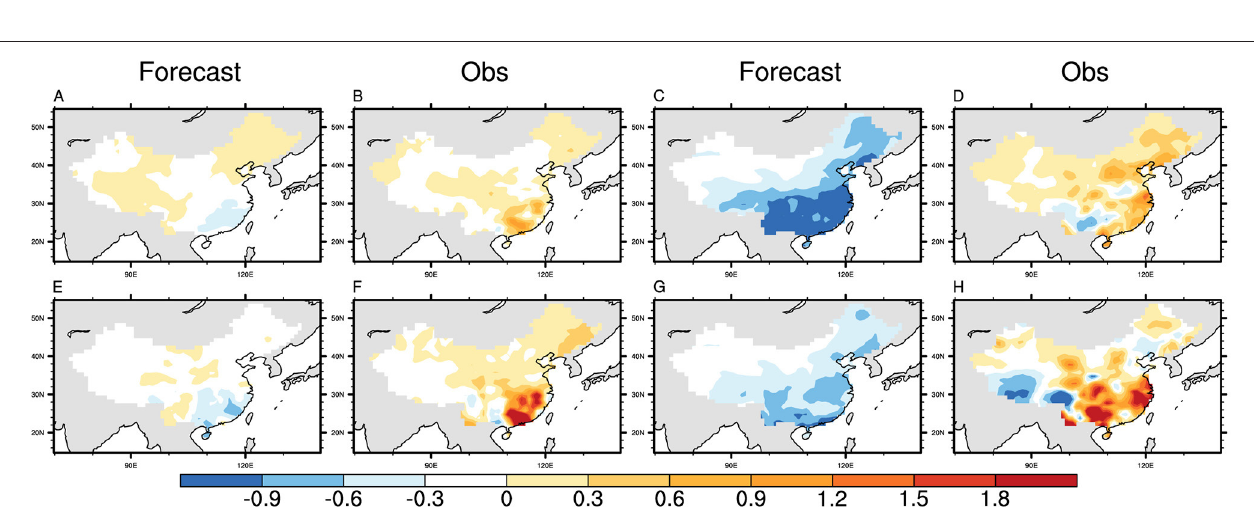
FIGURE 5 | Seasonal-mean MultiLLR model prediction and observations (mm/day) of Win-Spr (A,B,E,F) and Sum-Aut (C,D,G,H) seasons in the high-skill years (up panels) and low-skill years (low panels). The first and third columns represent the forecast, and the second and fourth columns represent the